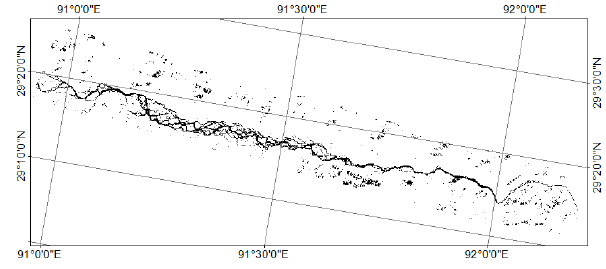
Figure 4. River extraction result using NDWI